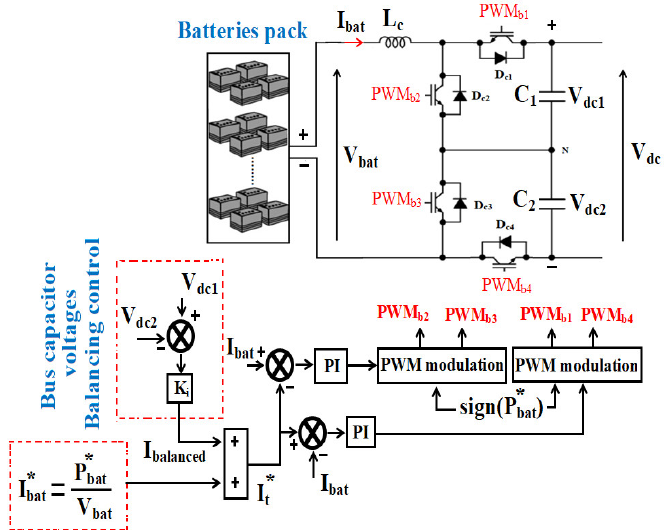
Figure 8. Battery current control and DC bus capacitor voltage balancing control method.